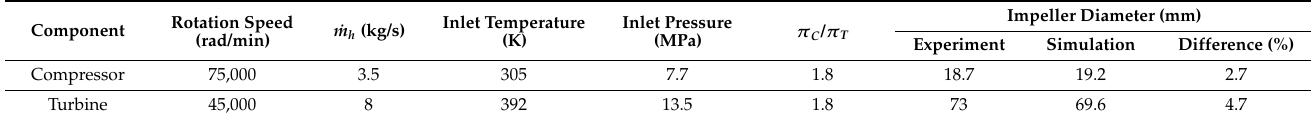
Table 3. Verification of turbomachinery model.